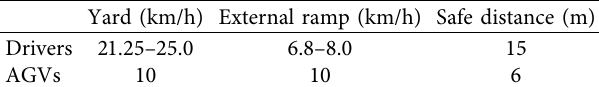
Figure 1: Parking space for vehicles in the yard of port (A) (source: Table 1: Vehicle speed and safe following distance in the simu- lation model.